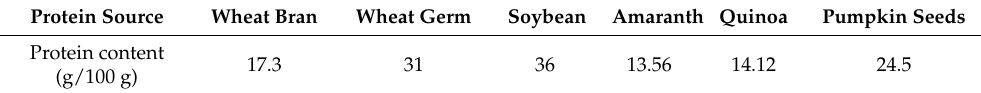
Table 2. Protein content of grains and seeds evaluated as supplement for Hirsutella citriformis strains growth in solid